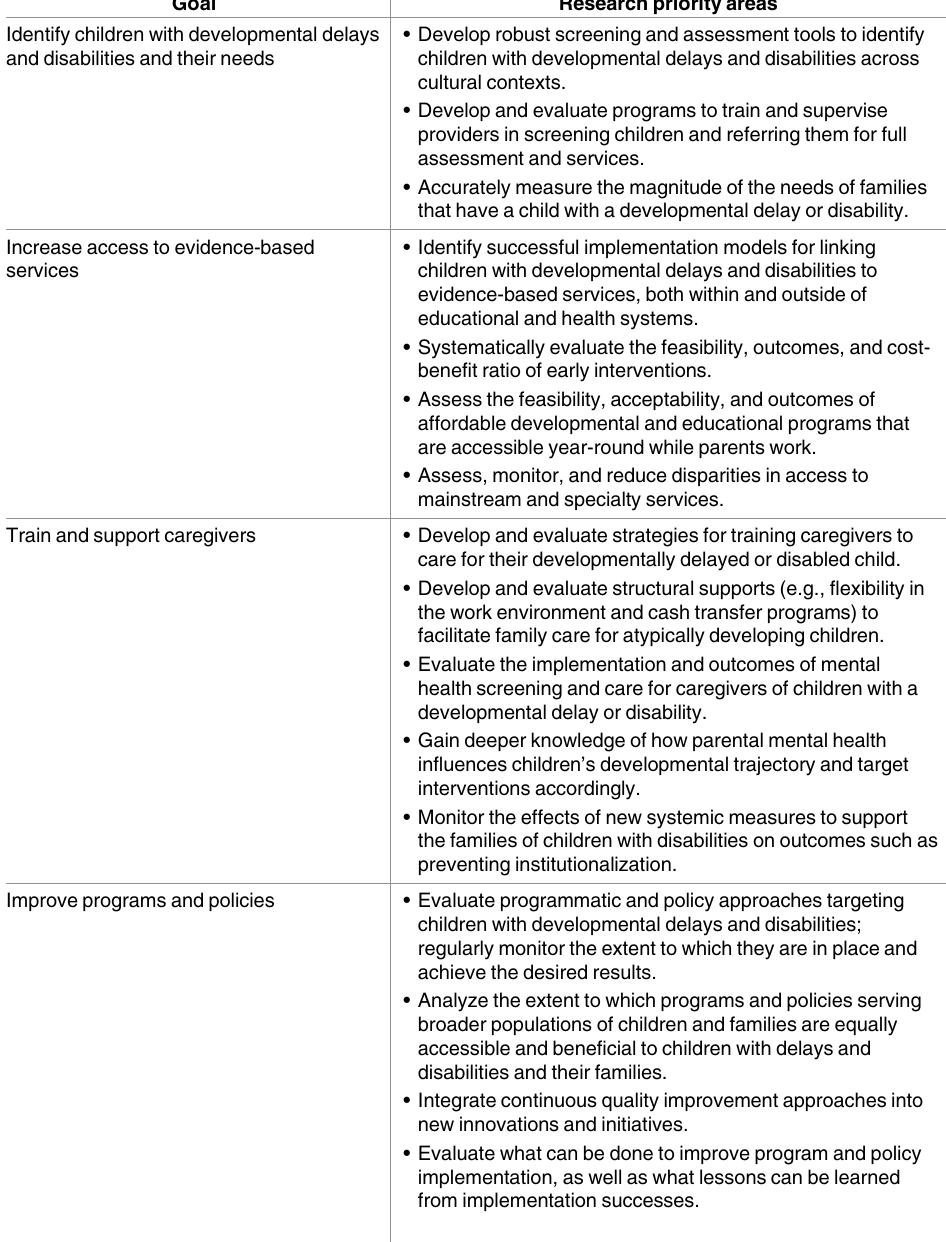
Table 3. Researchgaps for the identification and care of children with developmental delays and